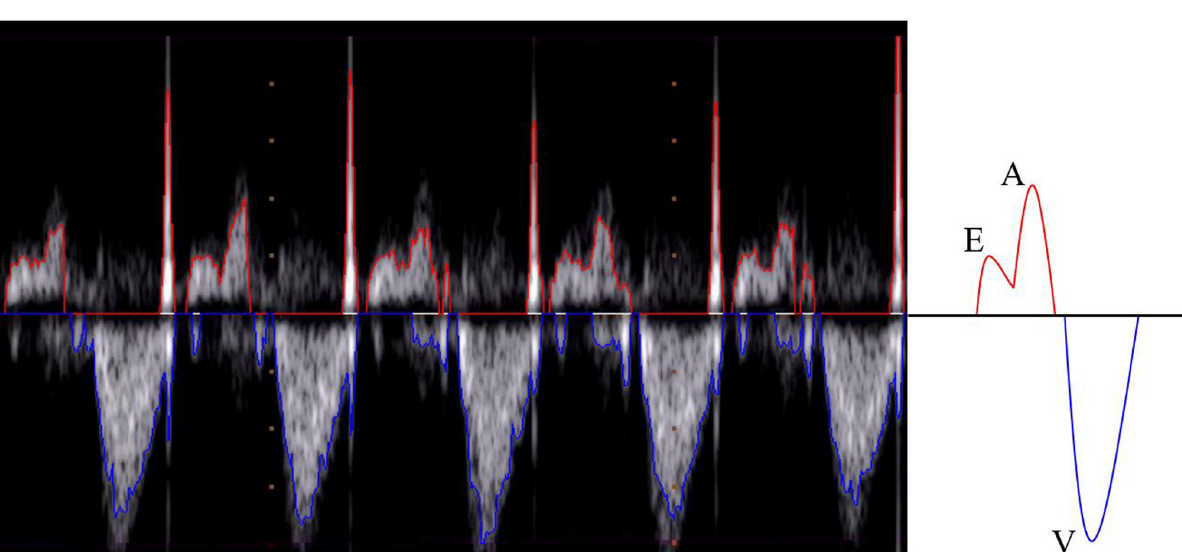
Fig 2. Pulsed-wave Doppler image. (Left) The initial segment of the image shows the first five beats from the first PWD image in our shared dataset. The image includes the upper (red line) and lower (blue line) envelopes. (Right) A graphical representation of the ideal waveform morphology of the envelope associated with a fetal beat, which was acquired using PWD with the apical five-chamber